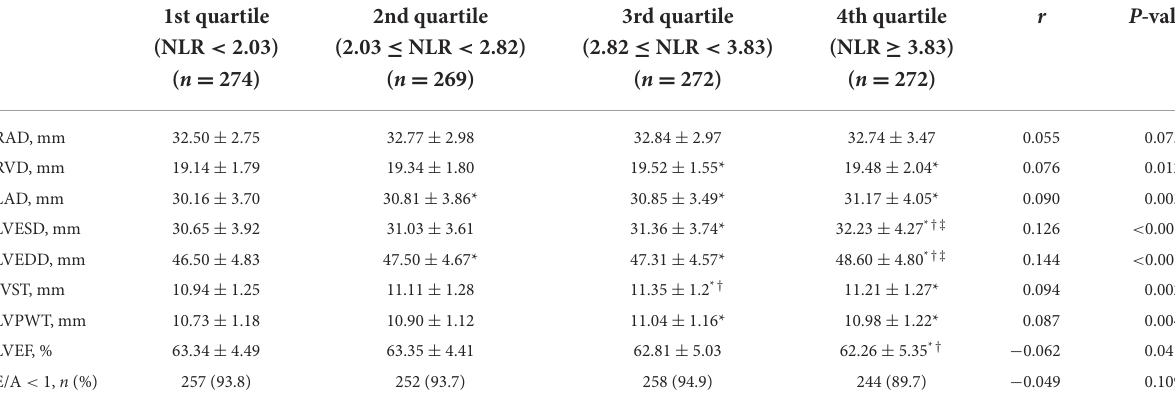
TABLE 2 Comparison of echocardiographic parameters among quartile NLR groups.